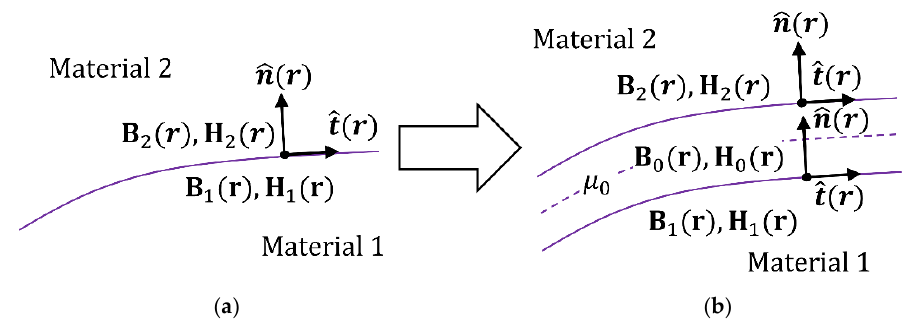
Figure A1. Virtual air gap creation process: ( a ) Magnetic materials 1 and 2 are in contact, and the surface is expressed by the position vector 𝒓 . In each material, 𝐁 1 (𝒓) and 𝐇 1 (𝒓) , 𝐁 2 (𝒓) and 𝐇 2 (𝒓) exist at vicinity of 𝒓 , respectively. The contact surface has normal vector 𝒏̂(𝒓) and tangent vector 𝒕̂(𝒓) . ( b ) A very thin “ virtual ” gap of air, namely virtual air gap, is created in the surface. Within this gap, 𝐁 0 (𝒓) and 𝐇 0 (𝒓) are derived by Equations (A4) or (A5), plus (A6).